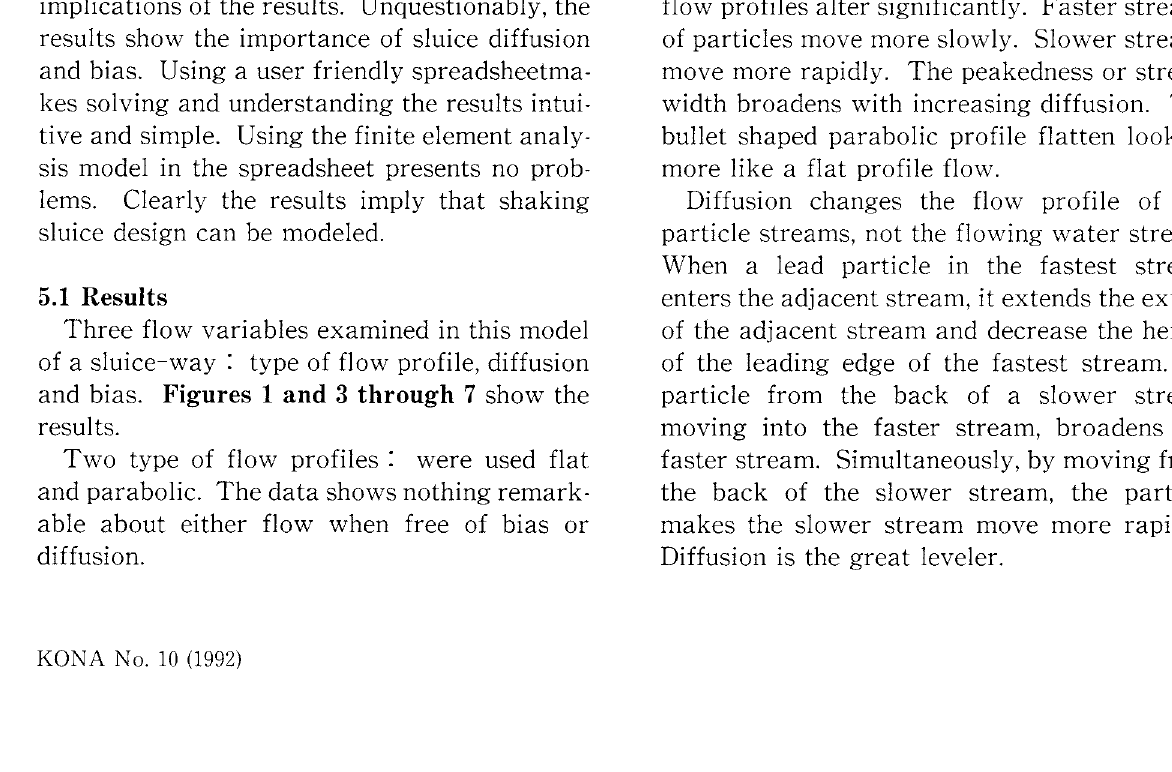
Fig. 6 Flat profile, high diffusion and high bias. Time of run 300